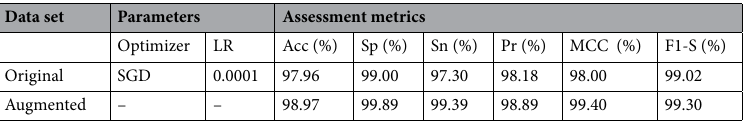
Table 2. CNN model performance with cross data